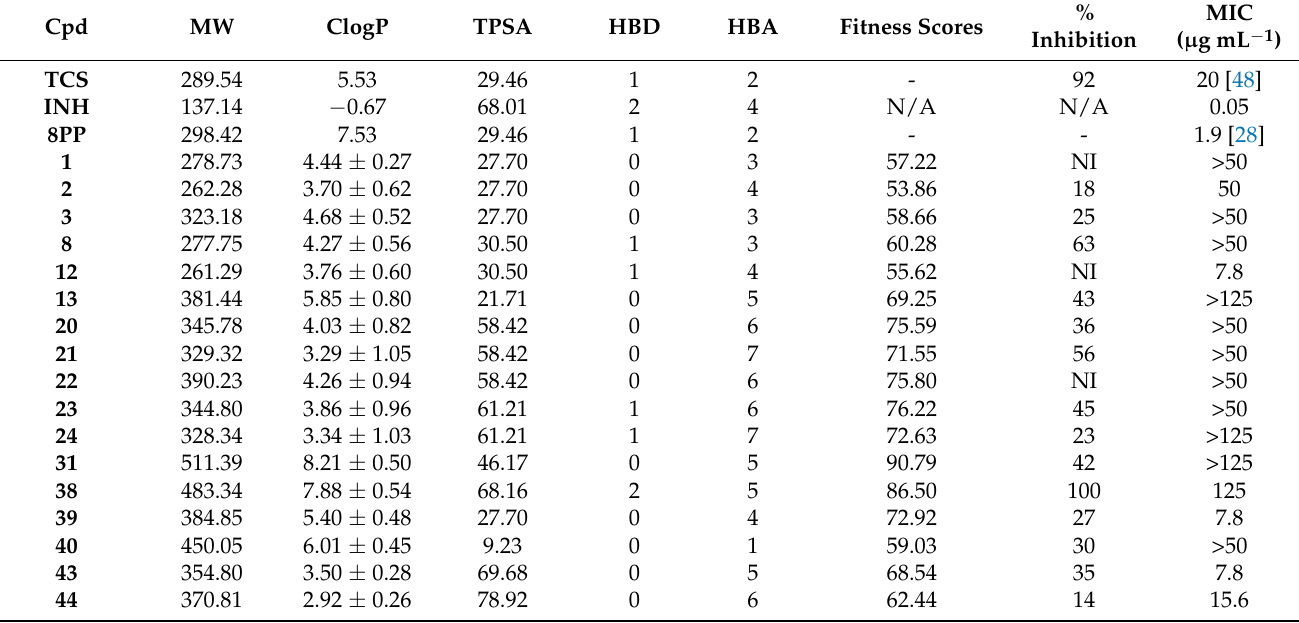
Table 1. Summary of the physical properties of the compounds reported in this paper and their percentage inhibition of InhA, MIC, GOLD fitness scores and drug like properties for the benzyl phenyl analogues, triazole linked derivatives and di -triclosan analogues as well as intermediate compounds. Molecular weight (MW) Total polar surface area (TPSA), Hydrogen bond donors (HBD) and Hydrogen bond acceptors (HBA) are also